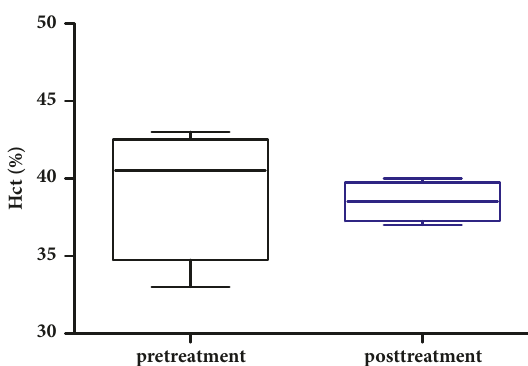
Figure 4: Hematocrit before and after chemotherapy treatments. The pretreatment result included 4 data points, each of which was generated using a sample collected before each treatment. The posttreatment result also included 4 data points, each of which was generated using a sample collected after each treatment. Result indicated that hematocrit did not alter significantly between pre- and posttreatments (p > 0.05, AVONA, GraphPad Prism).